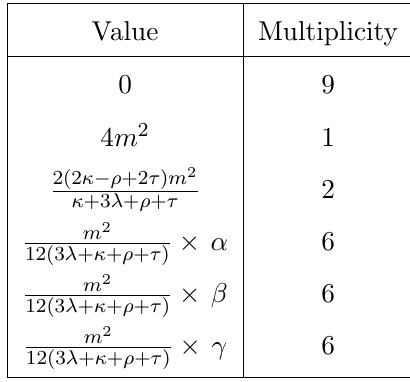
Table 8 . Scalar mass eigenstates for the SSB pattern SU(3) ! A 4 using a 15 of SU(3).